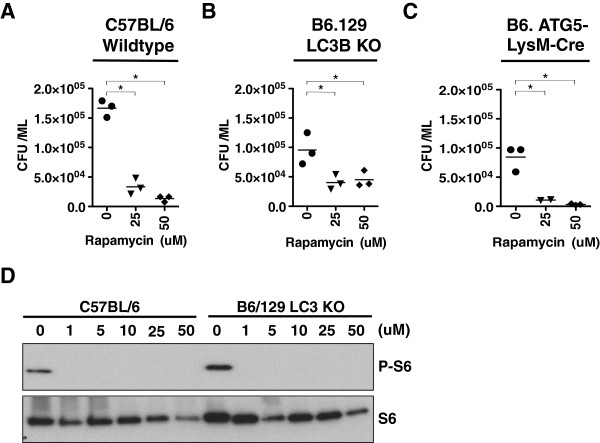
High doses of Rapamycin can kill M. smegmatis in wildtype and autophagy deficient macrophages. (A) Bone marrow derived macrophages from C57BL/6 mice were infected with M. smegmatis and treated with the indicated concentrations of Rapamycin. The cells were lysed and CFU was determined as described in Figure 2. (B-C) Bone marrow derived macrophages from B6.129 LC3KO mice and B6 LysM-ATG5 mice were isolated and treated as described above. For parts (A-C), shown are results representative of two independent assays per mouse strain. (D) Western blot of protein lysates of samples described in (A) and (B) for ribosomal S6 and phosphorylated ribosomal S6. Asterisks indicate p ≤ 0.05 drug treated groups versus DMSO treated cells.